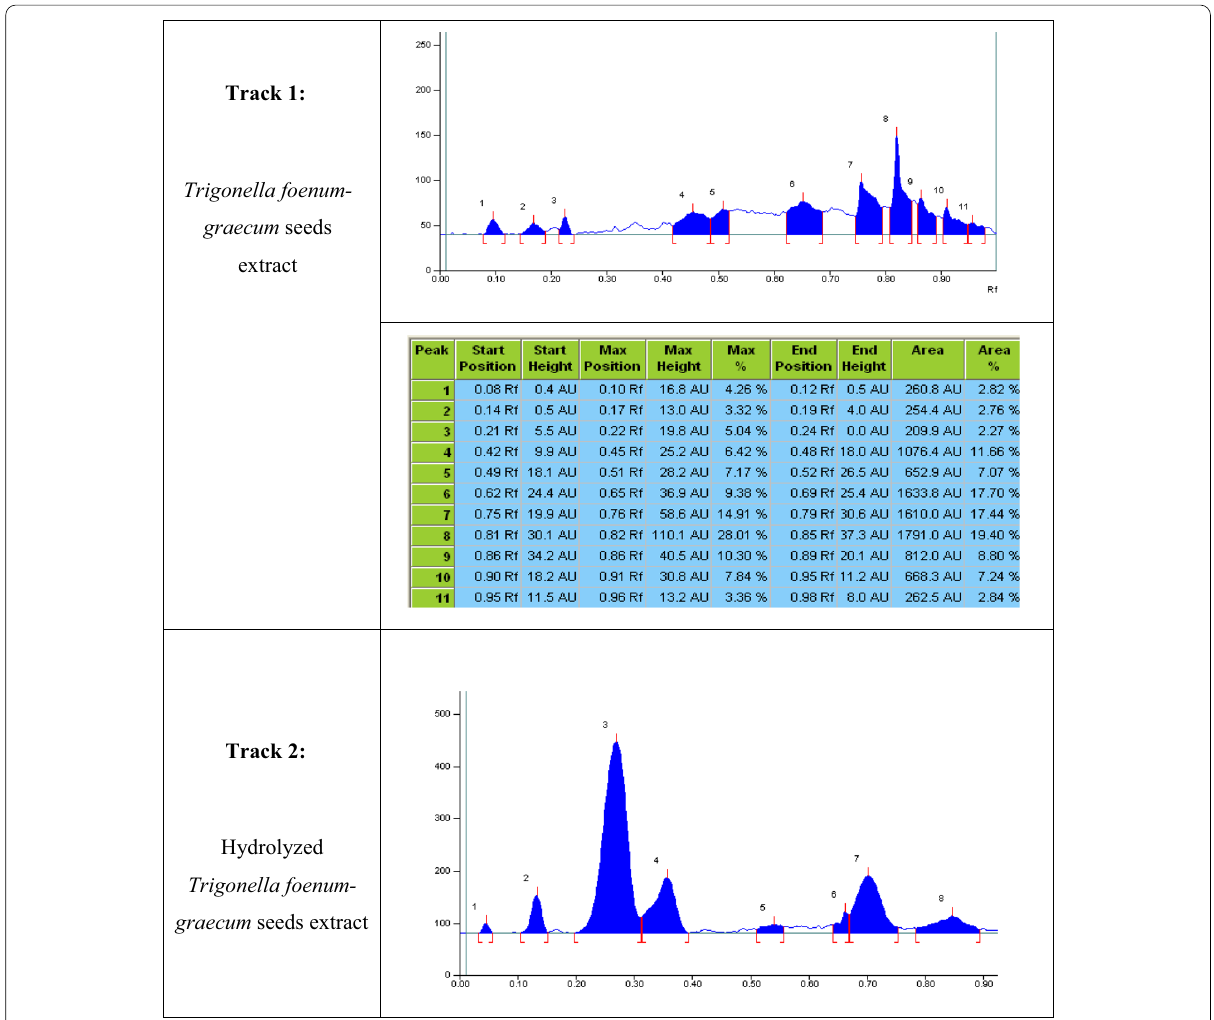
Fig. 4 HPTLC fingerprint profiles of Trigonella foenum-graecum seeds extract, coded ayurvedic formulation extract and Diosgenin reference standard at UV 254